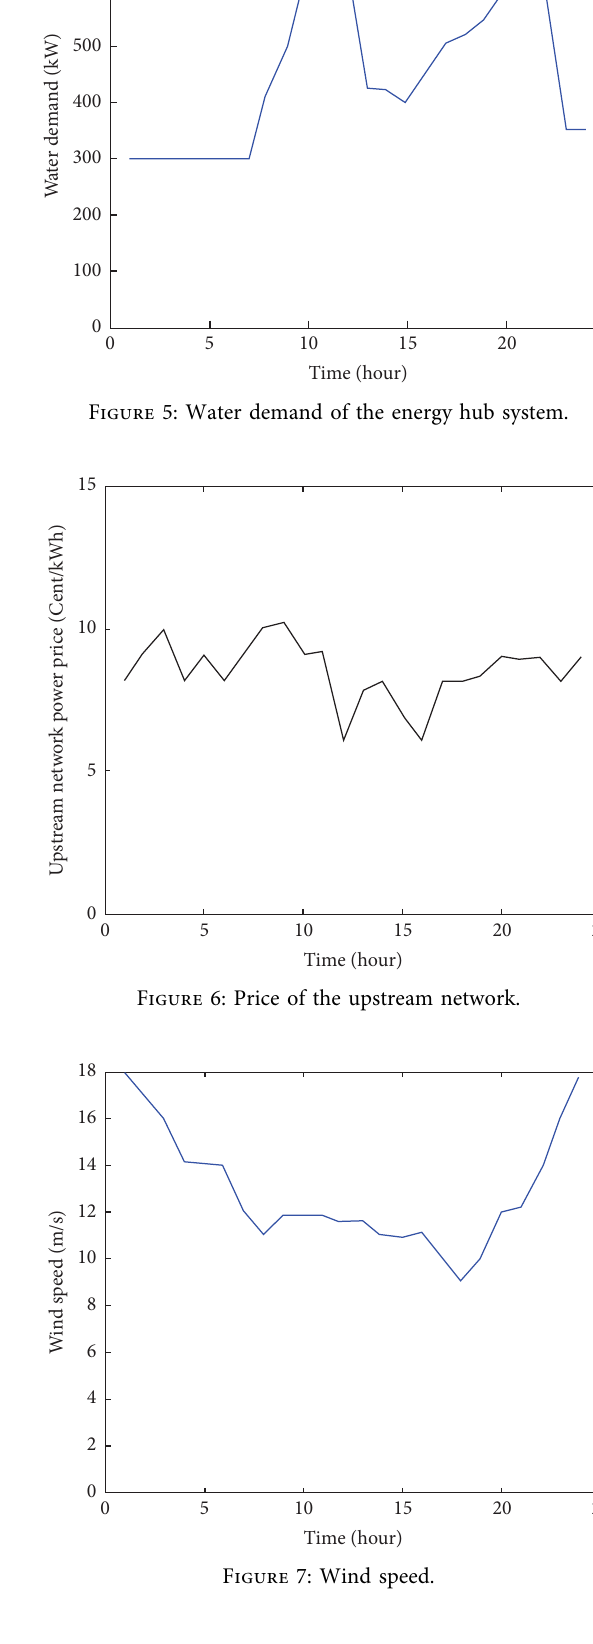
Figure 4: Gas demand of the energy hub system.